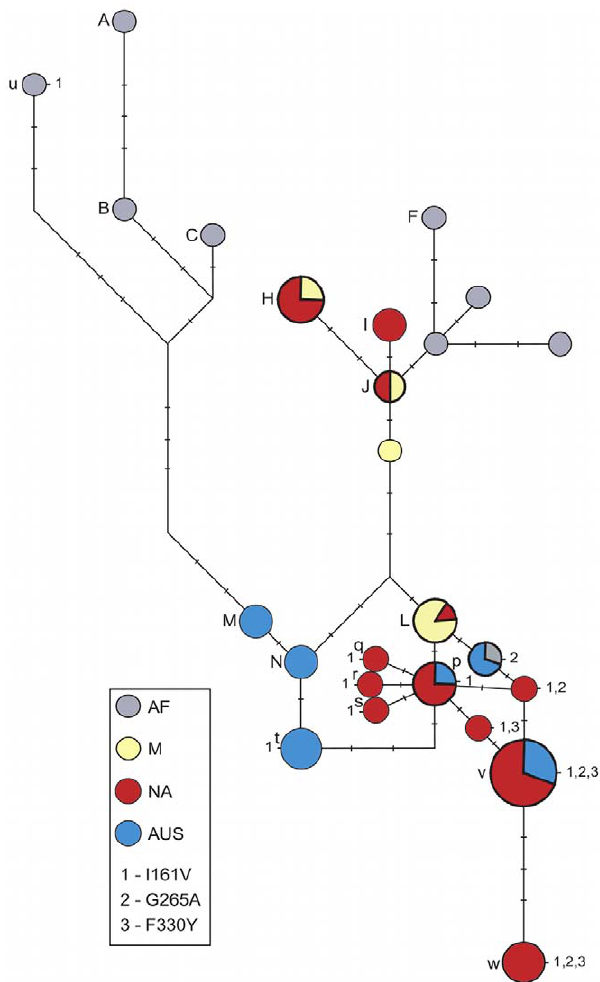
Figure 1. Haplotype network at Ace . Alleles containing mutations I161V, G265A and F330Y are numbered 1, 2 and 3 respectively. Sizes of the circles correspond to the number of identical sequences representing each haplotype; tick marks along a branch indicate the number of mutations between two neighbouring haplotypes. Sensitive haplotypes are labelled with capital letters and resistant haplotypes with lowercase letters. Note that our sample is enriched for resistant haplotypes. Resistant NA alleles containing a single mutation (all at the first site) appear to have arisen on the common out-of-Africa haplotype L, with one specific L-related allele (labelled p) present at the highest frequency. The resistant AUS alleles also cluster together. AUS resistant alleles containing a single resistant mutation in the first or second site appear to have arisen either on the background of the common out-of- Africa sensitive haplotype L, or on the background of the specifically AUS haplotype N. The alleles containing two mutations in NA (first plus second or first plus third sites) are all related to the sensitive L haplotype and the common resistant allele (labelled p) containing the mutation in the first site. The 3-mutation alleles are present both in NA and AUS populations (v and w) and are the most closely related to the sensitive L haplotype. There are two resistant alleles containing single mutations in the first and the second site that we detected in AF. One of these is very similar to the AUS alleles containing the second mutation and is likely a migrant from out-of-Africa back to AF. The other appears to have arisen in situ in AF